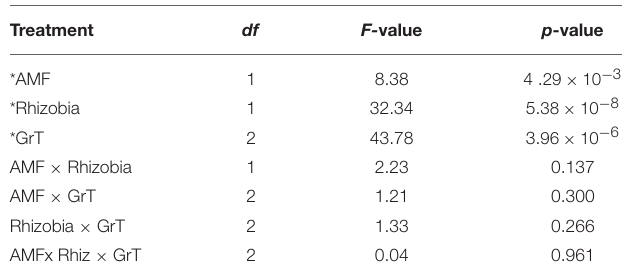
inoculated with AMF, rhizobia, or both symbionts, it exhibited